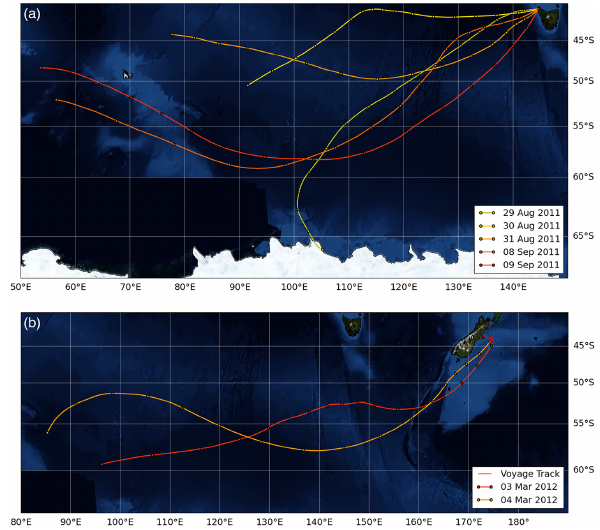
Figure 4. (a) HYSPLIT 96-hour back trajectory for the five clean marine samples from Cape Grim. (b) HYSPLIT 96-hour back tra- jectory for the two clean marine samples from the SOAP Voyage (Chatham